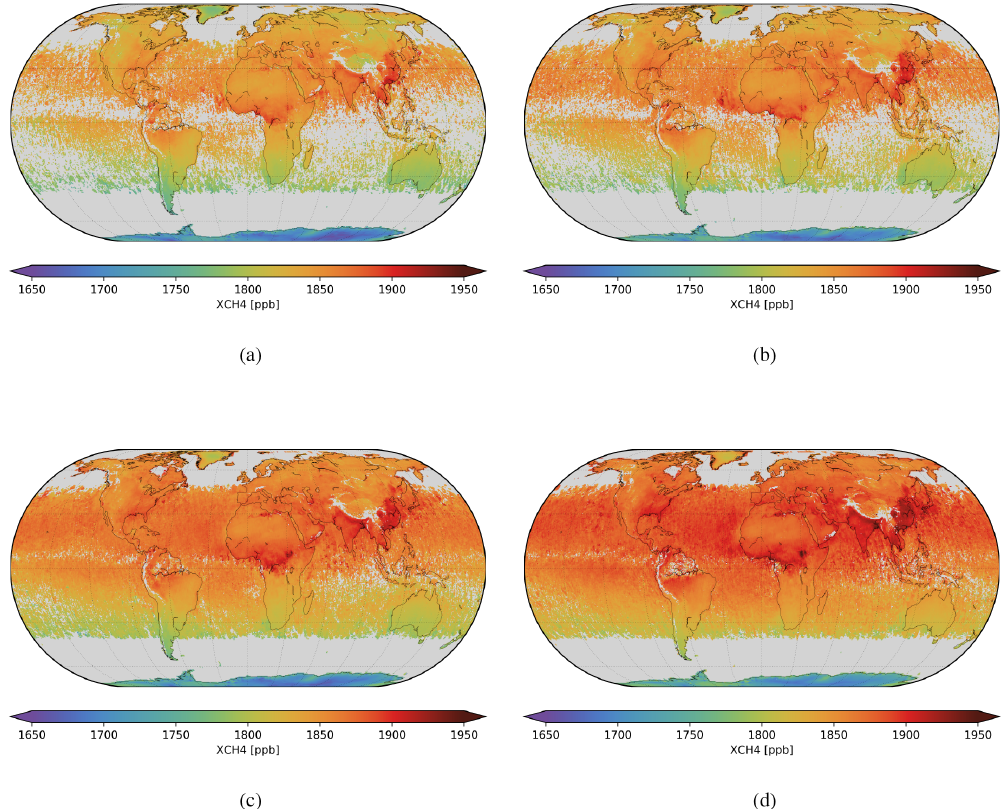
Figure 1. Global TROPOMI XCH 4 distribution for (a) 2018, (b) 2019, (c) 2020 and (d) 2021, averaged in a cylindrical equal-area grid with a 0 . 3 ◦ × 0 . 5 ◦ grid at the Equator. TROPOMI XCH 4 with the bias correction applied is shown (see Sect. 2). The difference in ocean coverage for 2018 and 2019 with respect to 2020 and 2021 is due to a bias in the VIIRS cloud fraction (see Sect. 3).